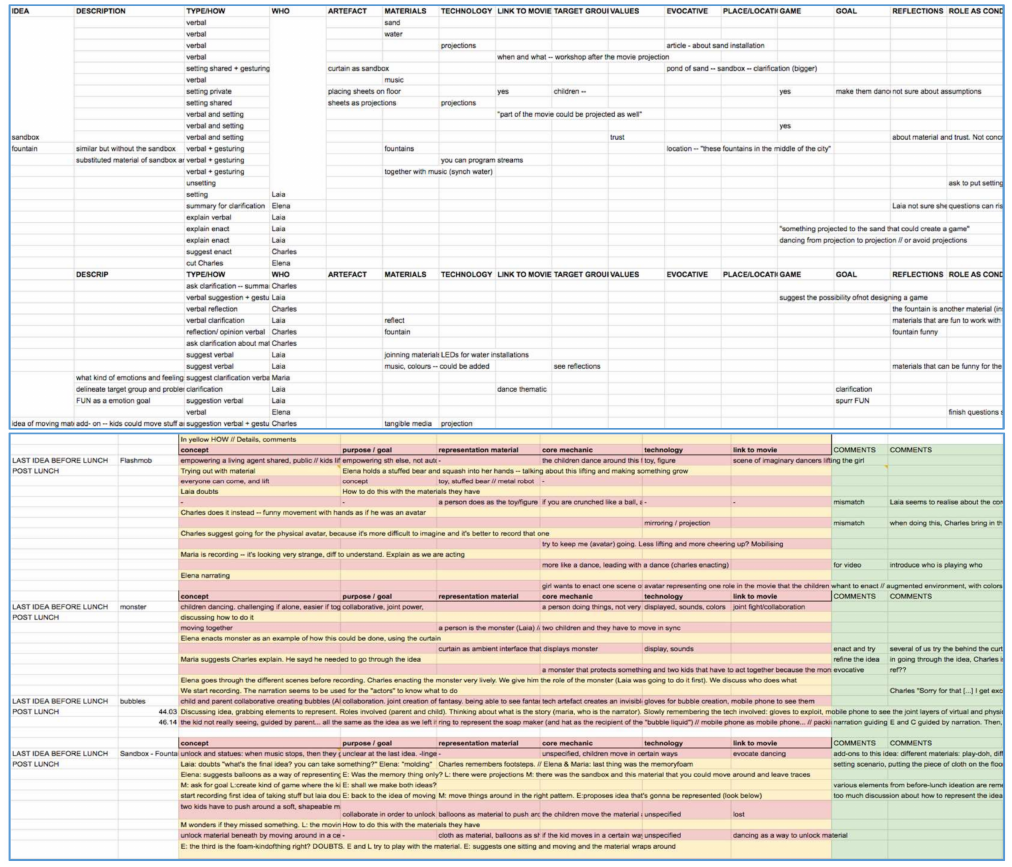
Figure 6. Screenshot of the codes of the datasheet for the Move:ie case. The different columns and rows can be observed. Some of them were color-coded to enhance the datasheet’s